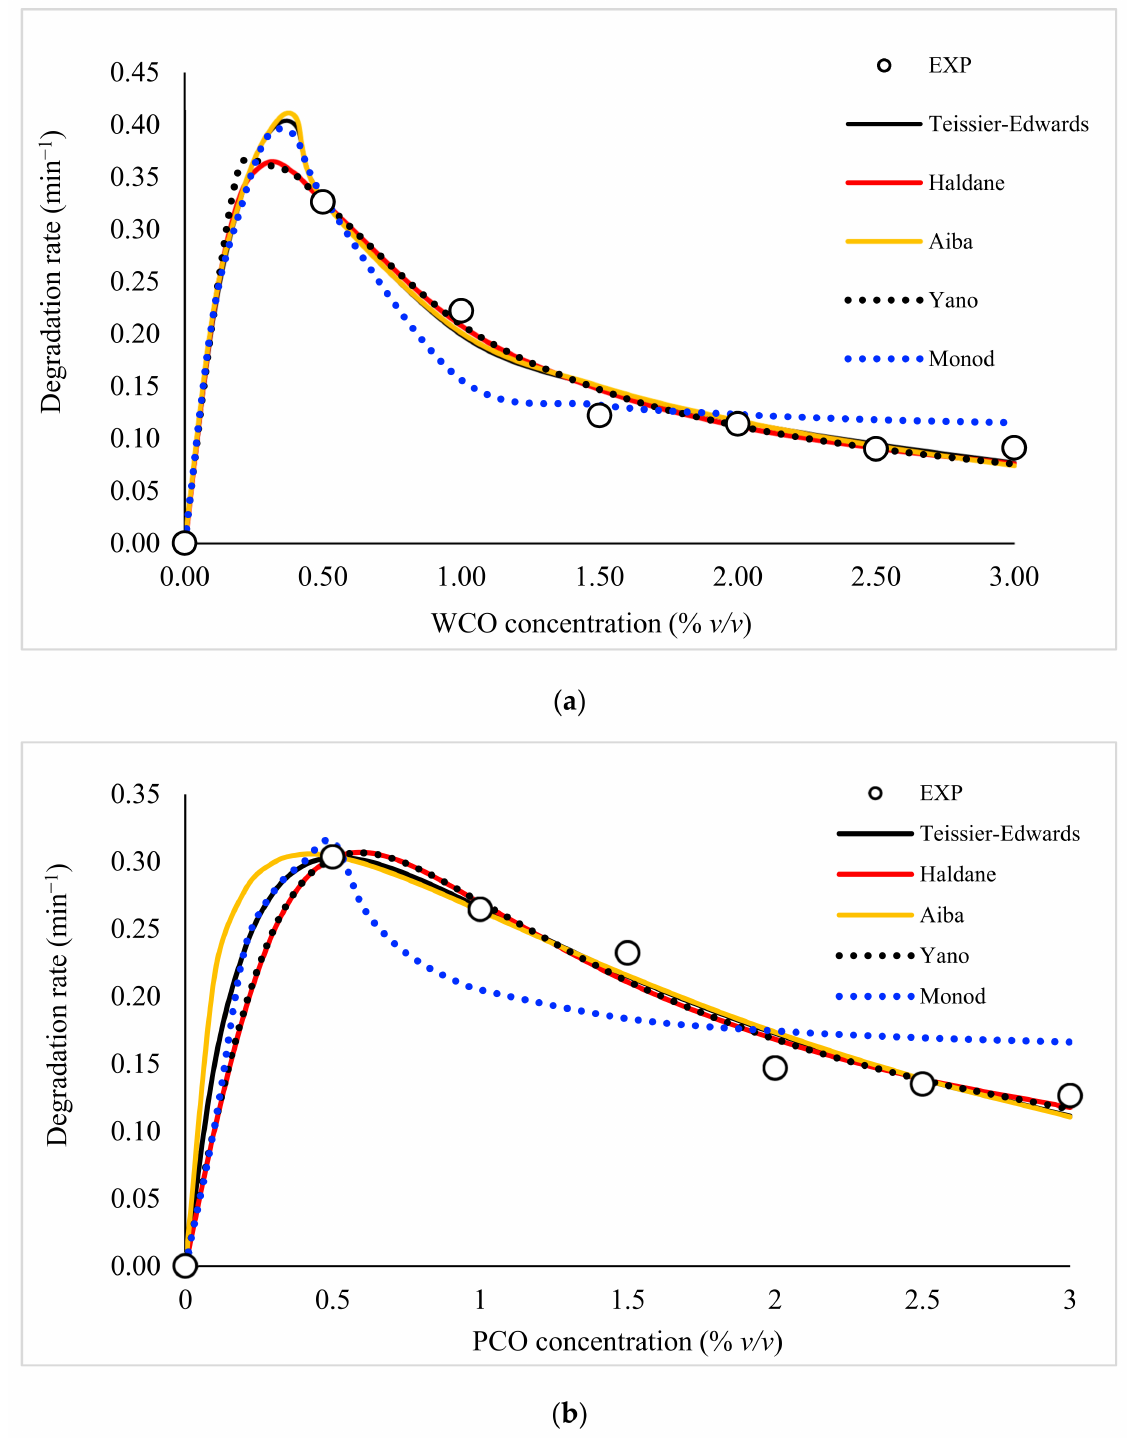
Figure 3. Kinetic modelling of ( a ) WCO and ( b ) PCO degradation using a range of standard non-linear models. The half-saturation constant ( K s ) and inhibition constant ( K i ) in the Haldane model for WCO biodegradation were 5.14% and 0.019%, respectively. Meanwhile, in the biodegrada- tion of PCO, the K s value was 16.65% while the K i value was 0.021%. As these values were obtained from the regressed equation, the maximum concentration of substrate tolerated (S m ) and the actual maximum degradation rate ( µ max ) could be calculated. The S m